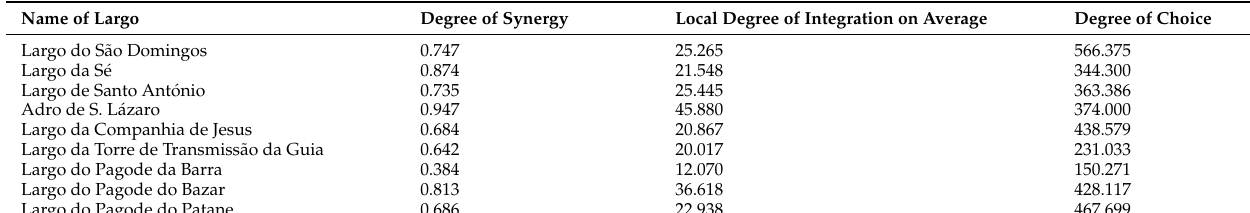
Figure 17. Largo do São Domingos, Largo do Pagode da Barra. Table 3. Syntax parameters of religion-related Largos.